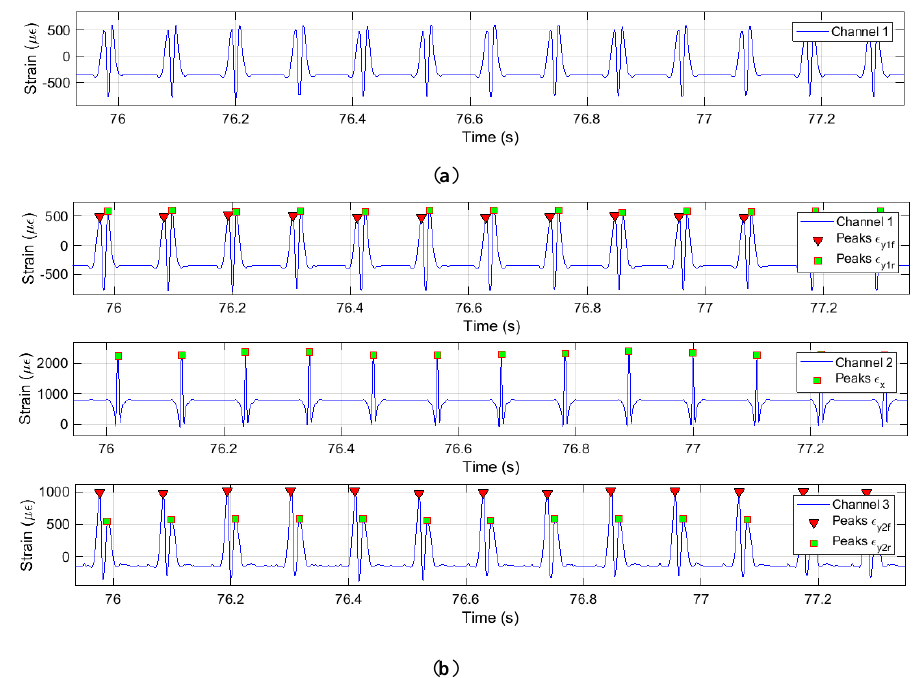
Figure 4. Intelligent Tire Strain time history at 0°, 0.8 bar, 500 N, 50 km/h. ( a ) Collected data of channel 1; ( b ) Detection peaks algorithm implemented.